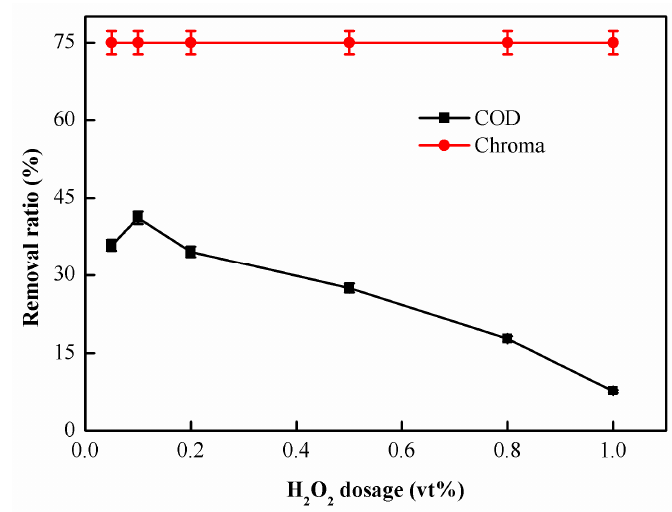
Figure 7. Effect of H 2 O 2 dosage on catalytic oxidation performance.